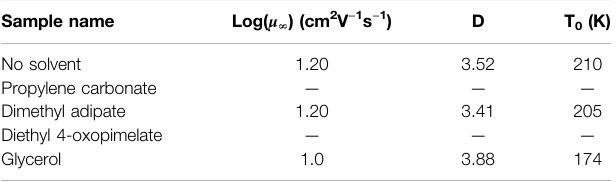
TABLE 4 | Fitting parameters of the Vogel-Fulcher-Tammann temperature dependence and mobility of conducting